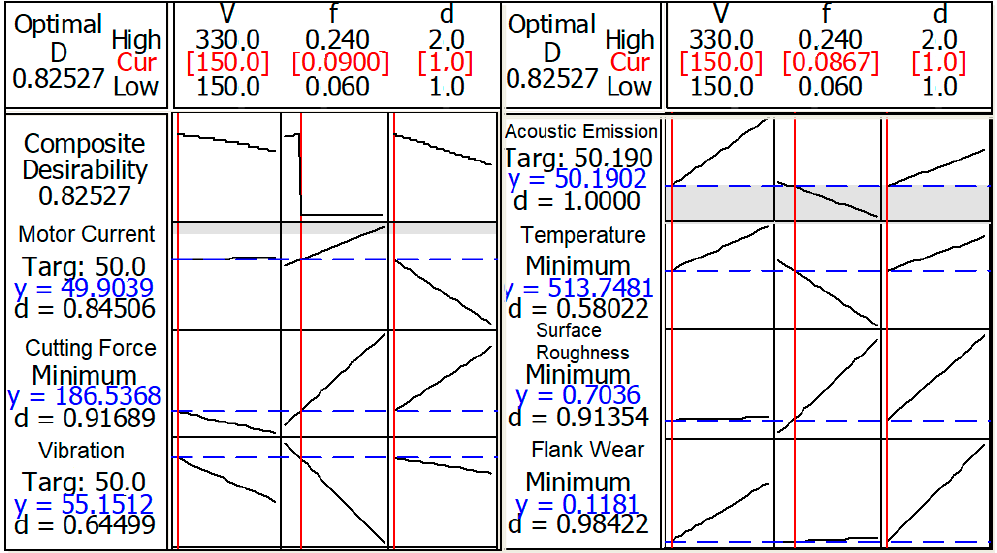
Figure 6. RSM-based optimization of variables.